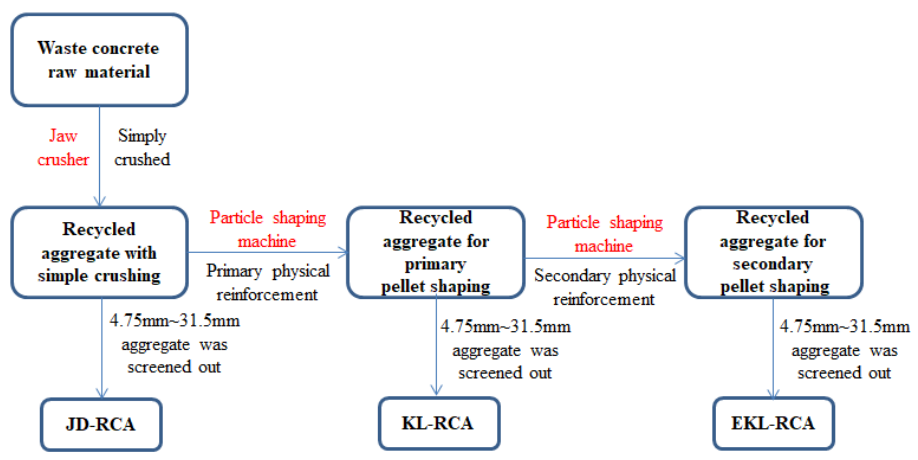
Figure 2. Preparation procedures of three kinds of RCA.